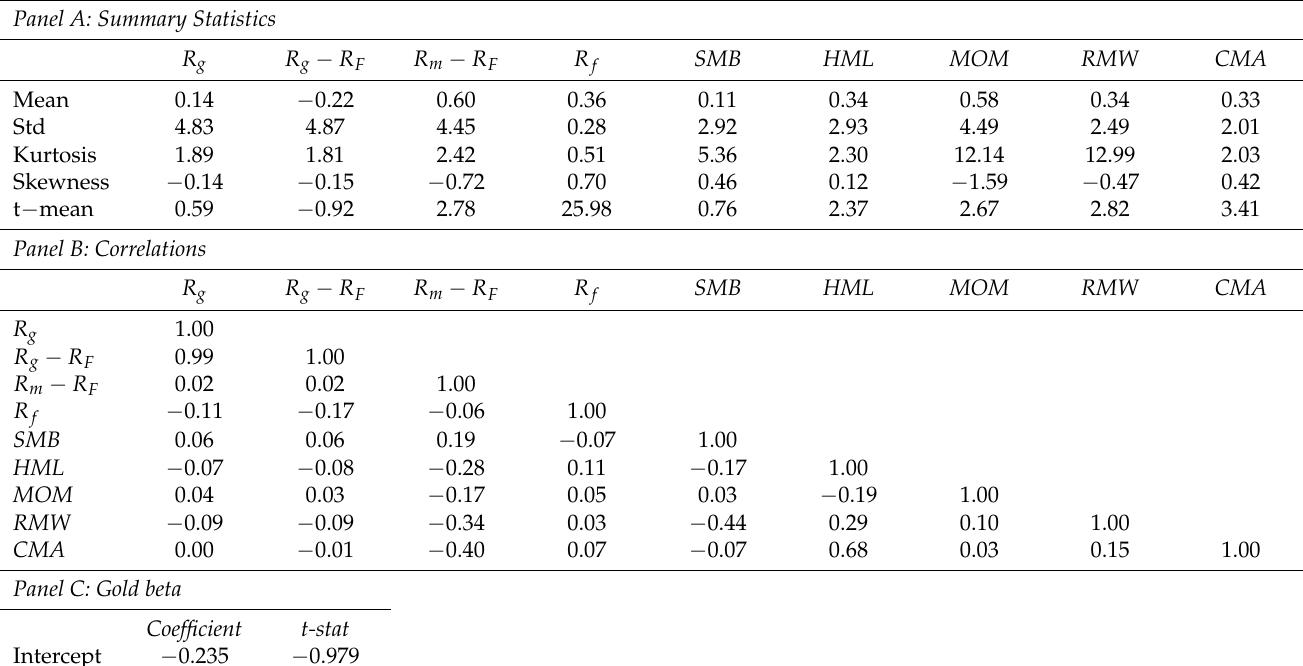
Table 1. Summary statistics for the returns on gold, market, Treasury bills, Fama–French and Carhart (Momentum) factors from January 1981 to December 2015. Panel A reports average monthly returns, standard deviation, kurtosis, skewness, and t-mean (ratio of the mean to its standard error). Panel B reports correlations among the factor returns. Panel C reports the results of the